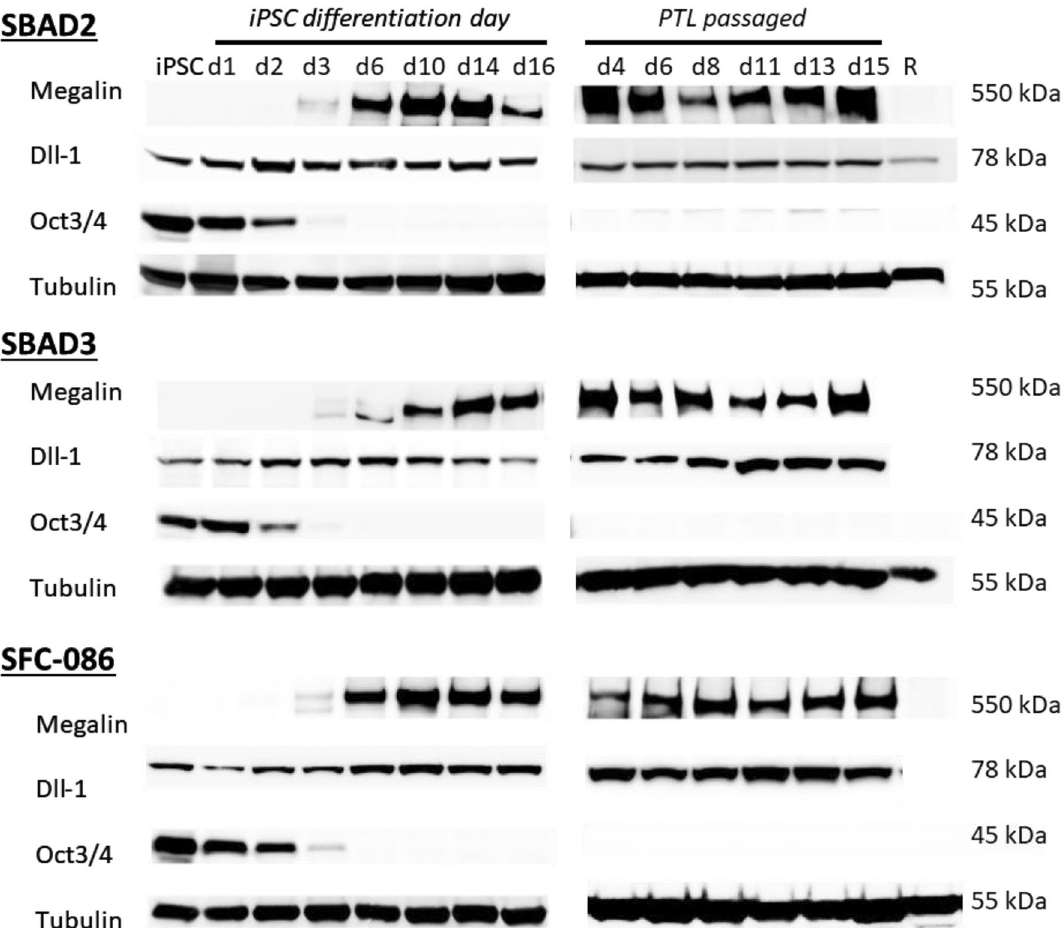
Figure 4. Western blot of time course of protein expression of stemness and differentiation markers. The iPSC lines SBAD2, SBAD3 and SFC-086 were differentiated on ECM as indicated. Cells were lysed at various time points during differentiation course. PTL were passaged on day 16 and grown for 15 further days. For each cell line at least 3 independent differentiations were performed. RPTEC/TERT1 cell lysates (R) were ran as a comparison. Samples were run on gradient gels and transferred to PVDF membranes using a semi-dry